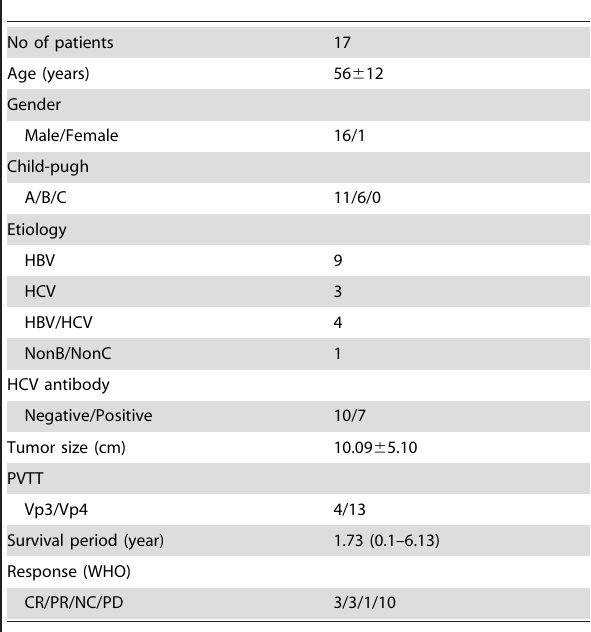
Table 1. Clinical parameters of HCC